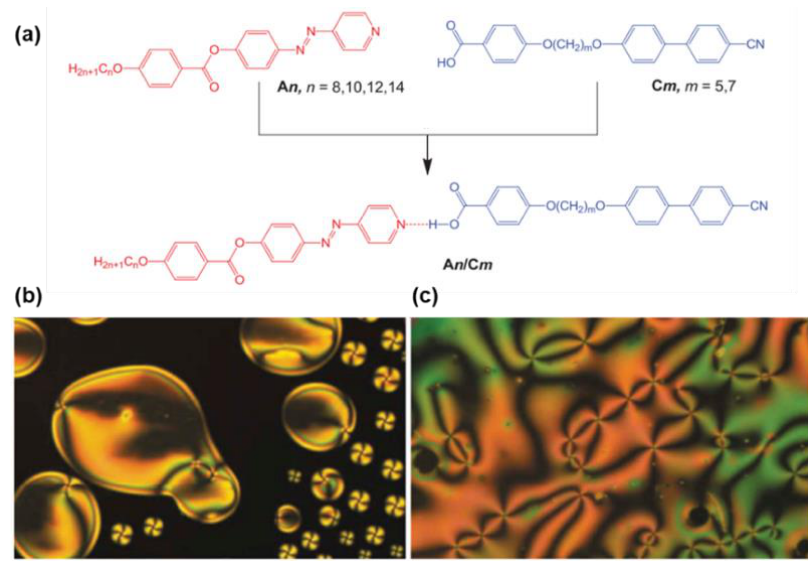
Figure 3. ( a ) Synthetic route to the hydrogen-bonded complex An/Cm; ( b ) Optical micrographs observed for the nematic phase of the supramolecular complex A8/C5 in homeotropic cell: nematic droplets at the transition from the isotropic liquid at T = 191 °C; ( c ) schlieren texture of the nematic phase showing four-brush defects at T = 150 °C. Reprinted with permission from Reference [33] . Copyright 2019, Taylor & Francis.